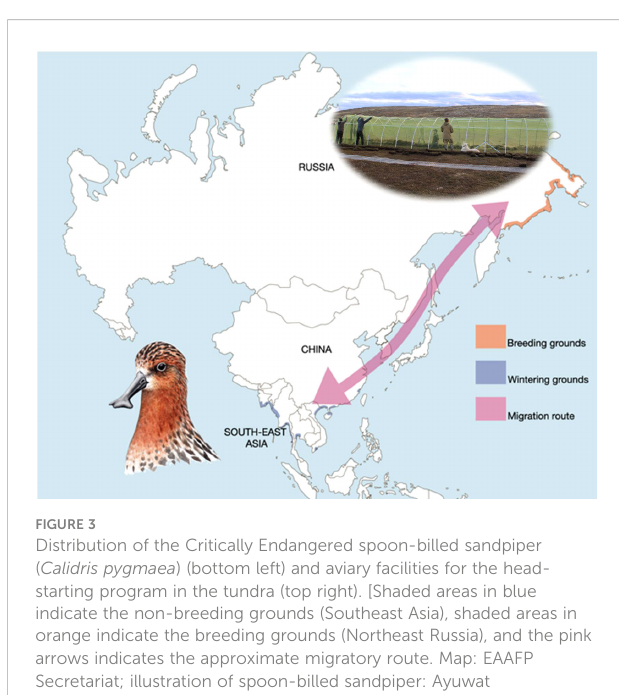
FIGURE 3 Distribution of the Critically Endangered spoon-billed sandpiper ( Calidris pygmaea ) (bottom left) and aviary facilities for the head- starting program in the tundra (top right). [Shaded areas in blue indicate the non-breeding grounds (Southeast Asia), shaded areas in orange indicate the breeding grounds (Northeast Russia), and the pink arrows indicates the approximate migratory route. Map: EAAFP Secretariat; illustration of spoon-billed sandpiper: Ayuwat Jearwattanakanok; photo of aviary facilities: Sayam U.